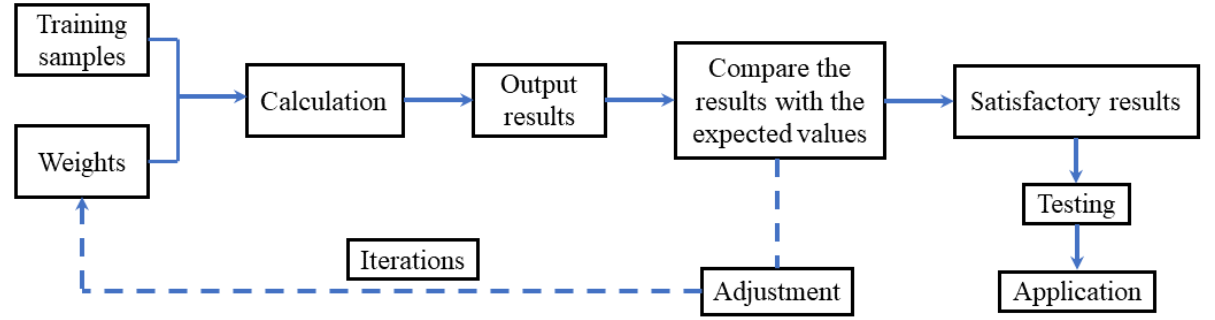
Figure 8. Steps for training the BP neural network.